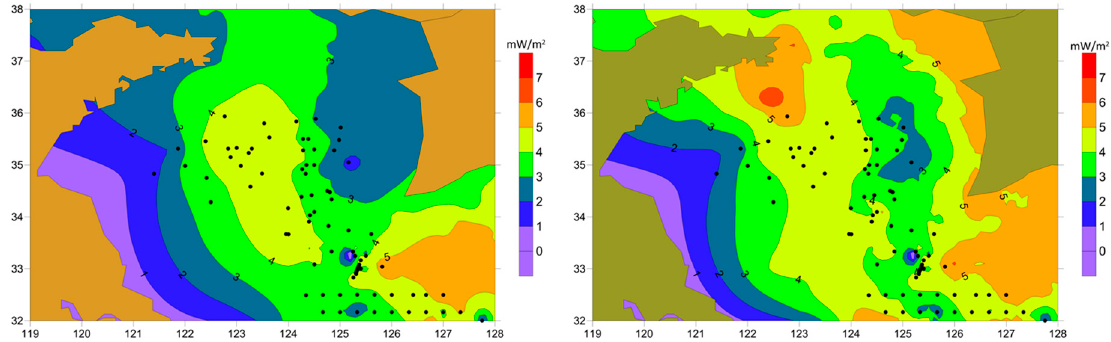
Figure 9. Bottom water temperatures in February ( left ) and August ( right ) in the Yellow Sea.